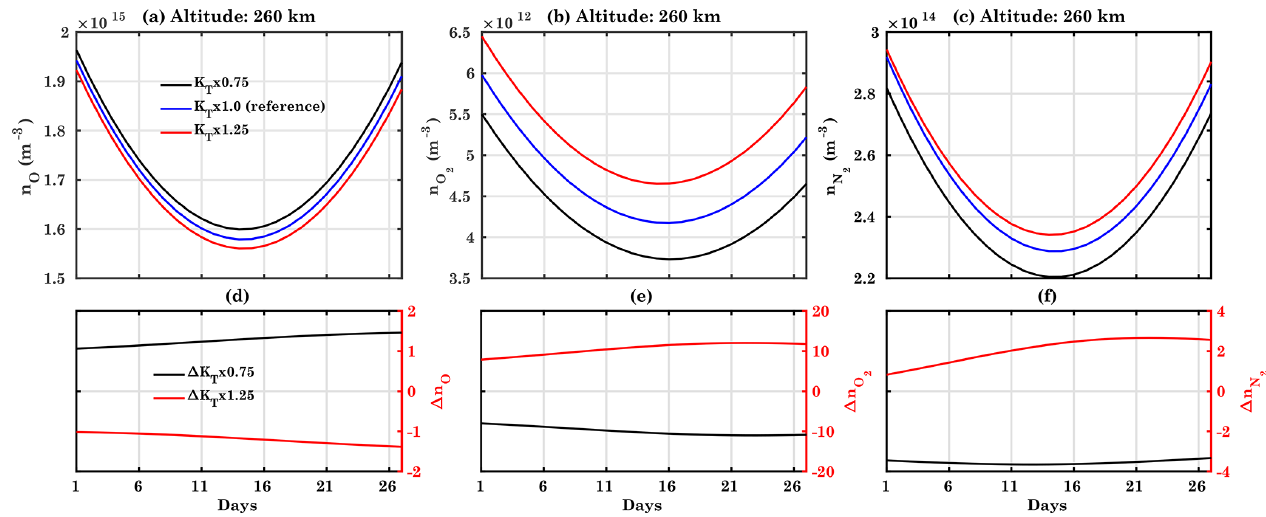
Figure 8. Variation of the CTIPe-simulated (a) n O , (b) n O (blue), and K T × 1 . 25 (red) (upper panel) for pressure level 12 (260km). The percentage difference between the K T × 1 . 0 run (blue curve) and the runs with modified eddy diffusion conditions, K T × 0 . 75 (black) and K T × 1 . 25 (red), is shown in the lower parts of the panels.